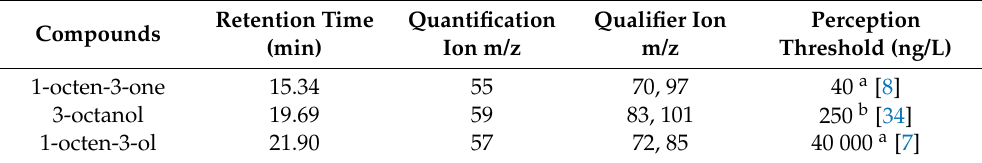
Table 2. Retention time, quantification and qualification ions of pure analytical C8 compounds analyzed by